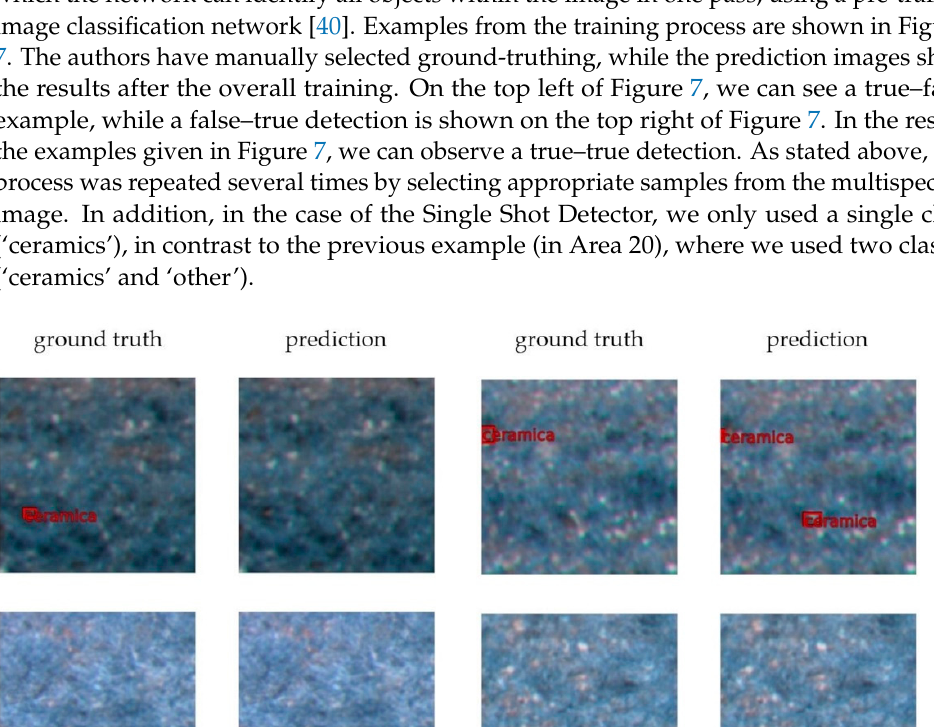
Figure 8. Potsherd detection (points) using the Single Shot deep learning algorithm over Area 6. The various colours indi- cate confidence level.